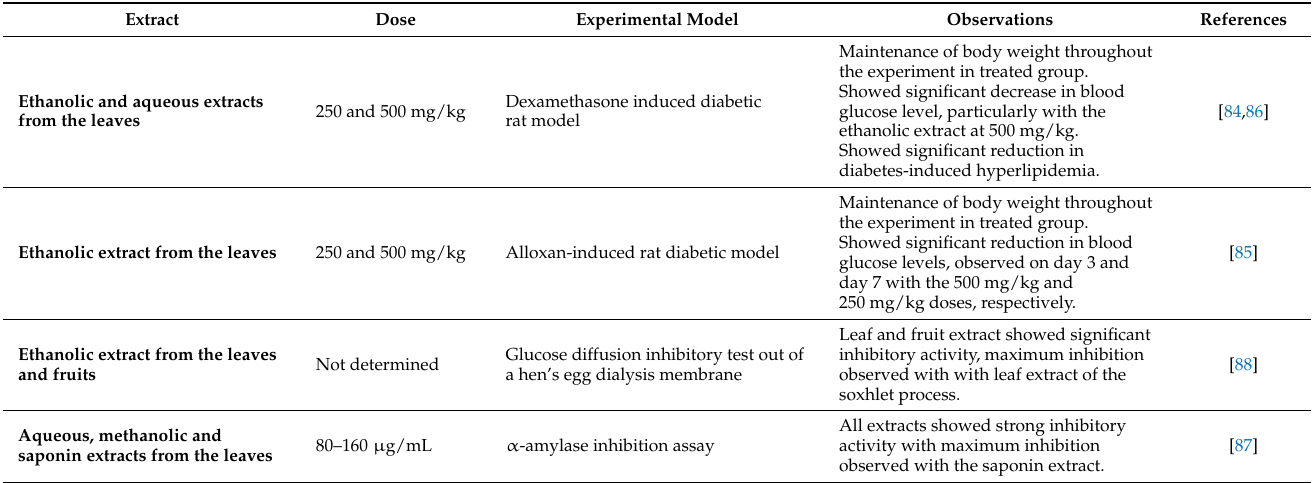
Table 8. The antidiabetic effects of Ziziphus nummularia